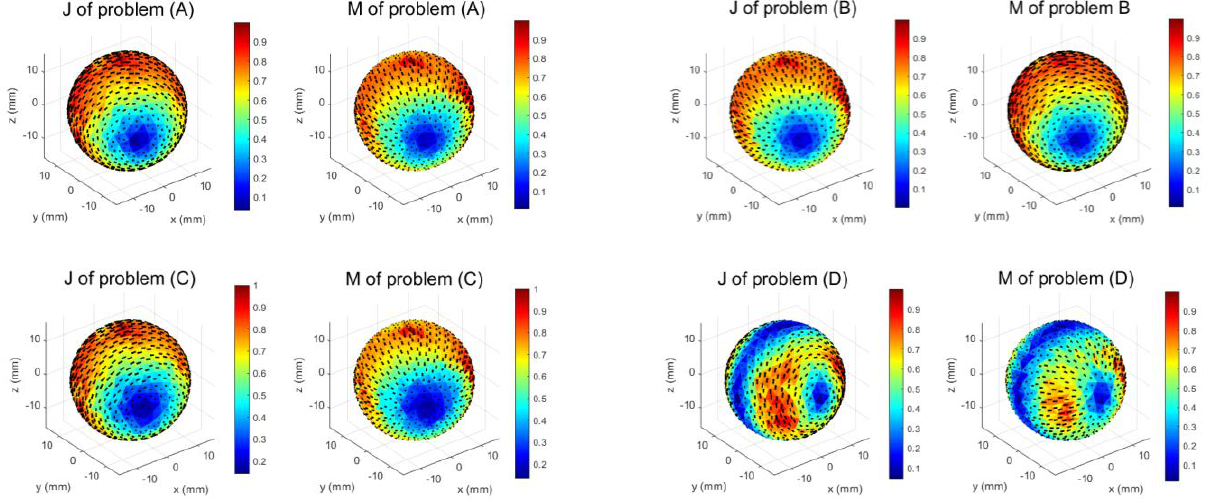
Figure 14. Characteristic electric and magnetic current distributions of the modes resonating near 2.95 GHz for the four different problems at 2.0 GHz, where the left column represents electric current and the right column represents magnetic current in every sub-figure.